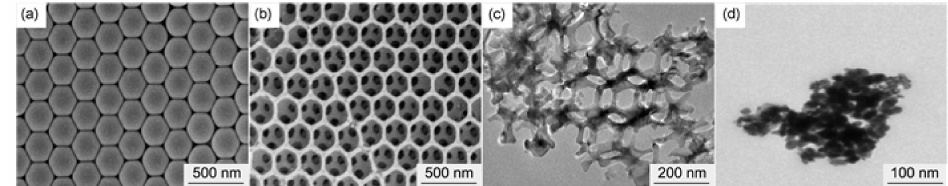
Figure 12. SEM image of ( a ) colloidal crystal template of polystyrene (PS); ( b ) SEM image of nanoporous CoFe 2 O 4 ; ( c ) TEM image of nanoporous CoFe 2 O 4 ; ( d ) TEM image of nanospheres CoFe 2 O 4 . ( a – d ) Reproduced with the permission of ref. [73]. Copyright 2016, Acta Physico- Chimica Sinica.